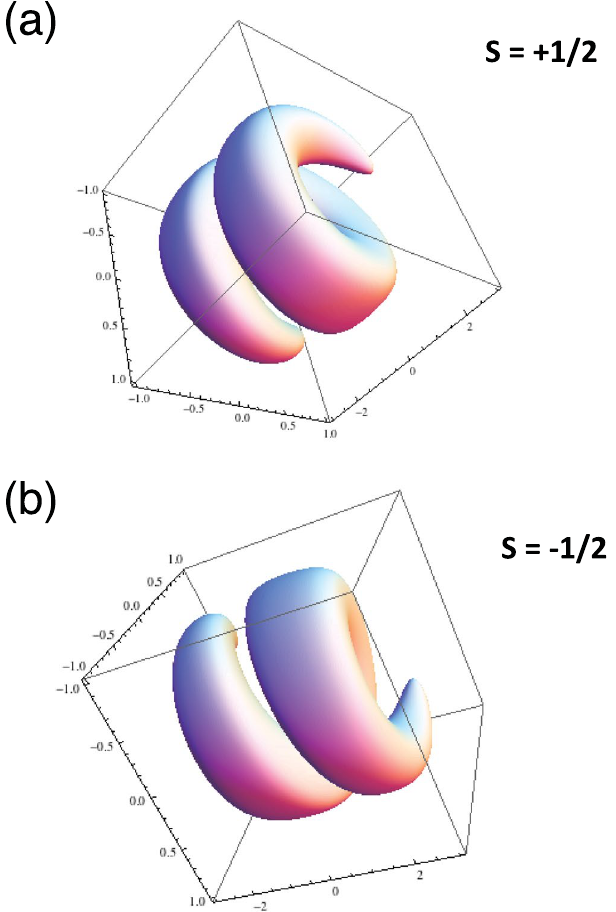
Figure 1. Electron density perturbations associated with twisted plasmon solutions with semi-integer topological charge s = ±